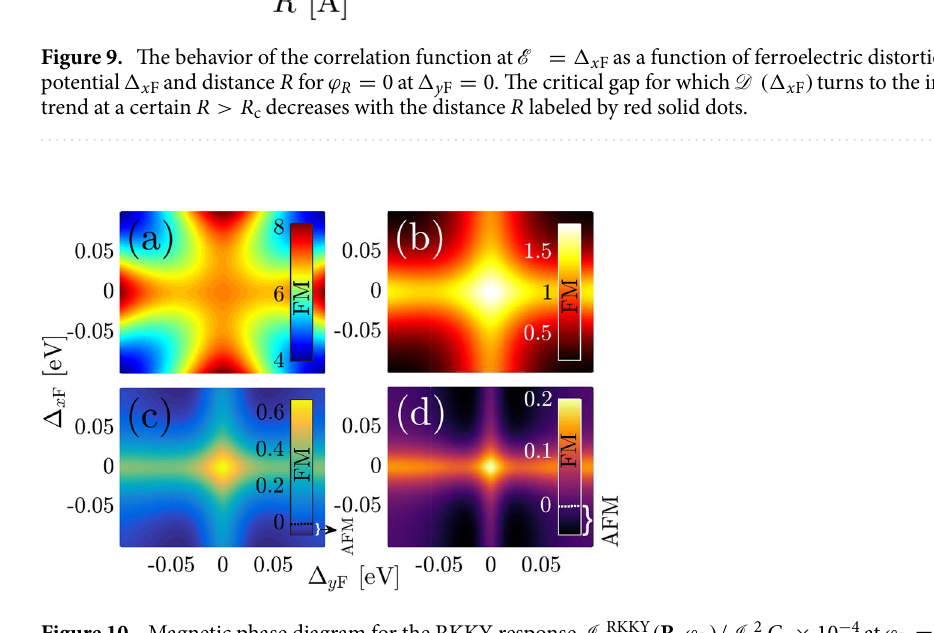
Figure 10. Magnetic phase diagram for the RKKY response J RKKY αα ( R , ϕ R )/ J 2 C t ferroelectric distortion potentials along both x - and y -directions at ( a ) R 70 and ( d ) R =